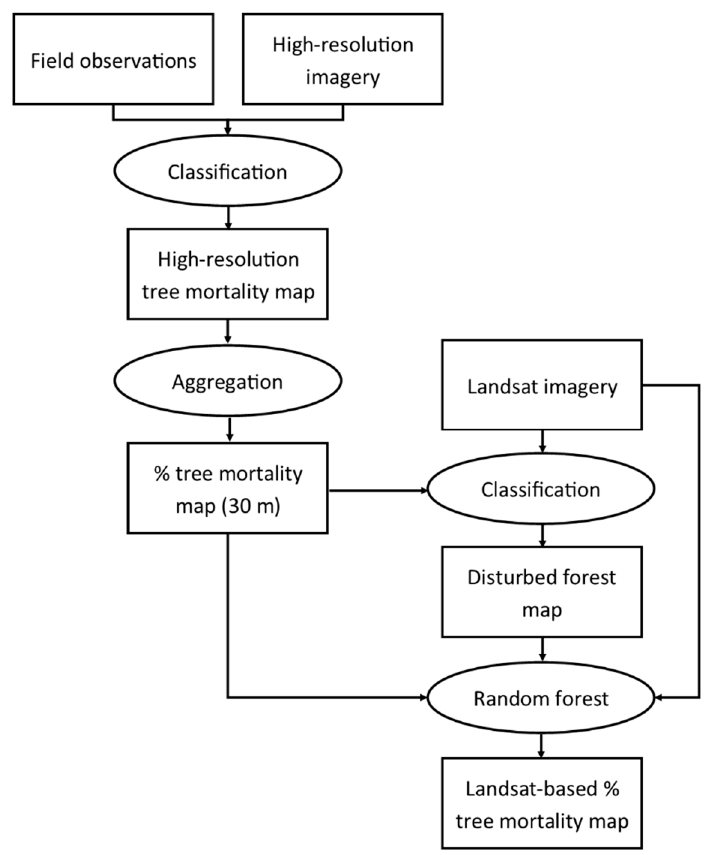
Figure 2. Overview of how field observations, high-resolution imagery, and Landsat imagery were used to create maps of percent tree mortality. This process was repeated for each of the three study